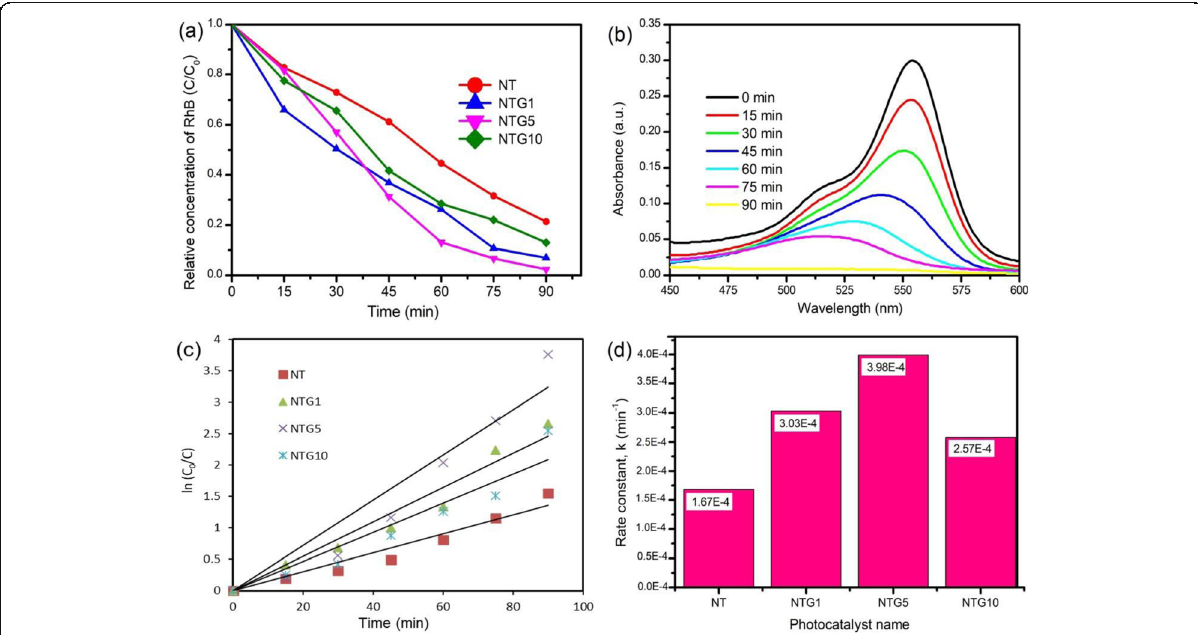
Fig. 8 (a) Effect of rGO loads on the degradation of RhB dye by different photocatalysts, (b) UV-vis absorption spectra of RhB for NTG5 nanocomposite as a function of irradiation time, (c) Relation between irradiation time and ln(c/c 0 ) and (d) Pseudo first-order rate constants for photocatalytic degradation experiments of RhB with different photocatalysts. Here, the solution pH =